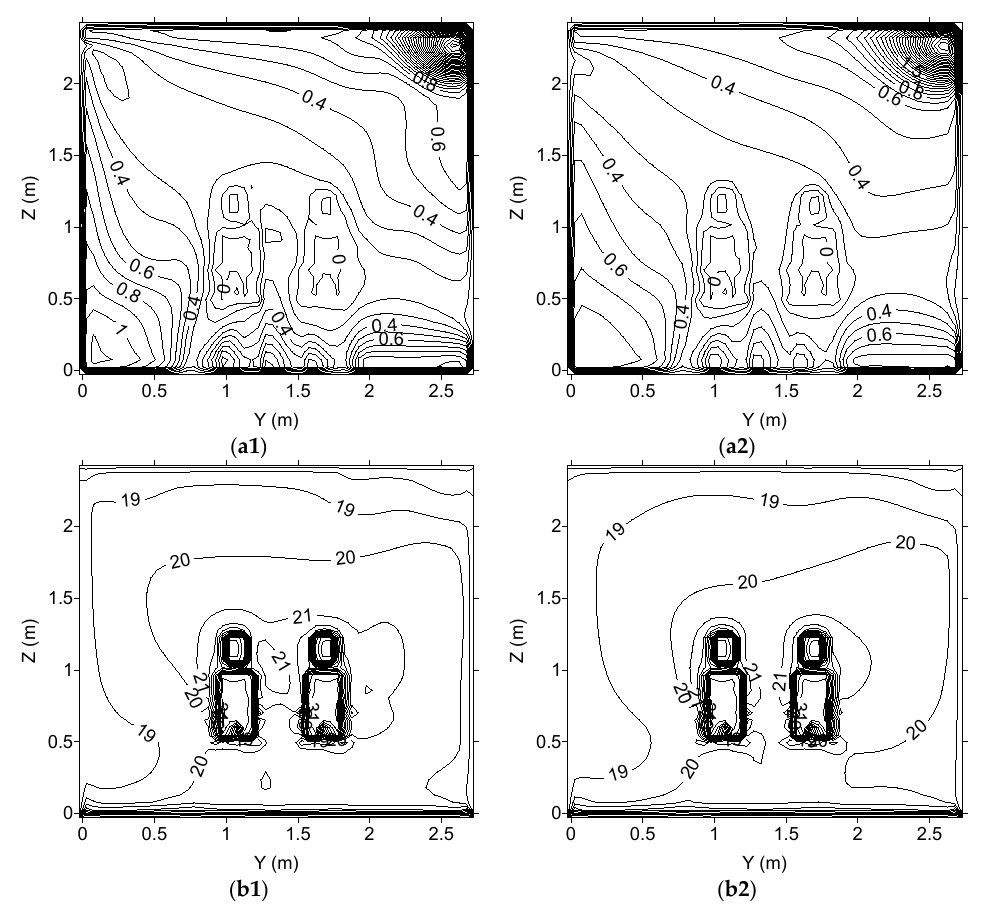
Figure 4. Air velocity ( a1,a2 ) and air temperature ( b1,b2 ) fields in the plan located at X = 130 cm (X23), numerically calculated. ( a1,b1 ) are associated with the k ‐ epsilon turbulence model, and ( a2,b2 ) are associated with the RNG turbulence model.